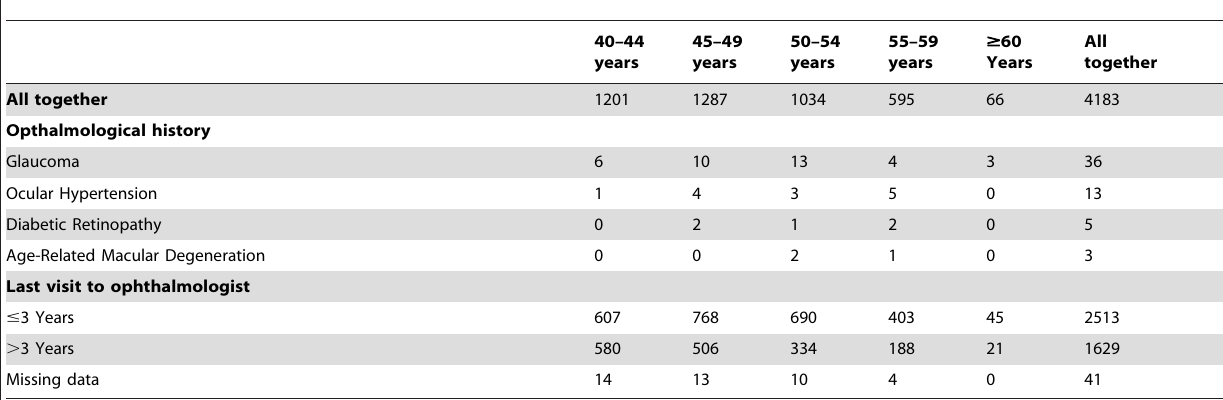
Table 4. Ophthalmological history subdivided in glaucoma, ocular hypertension, diabetic retinopathy, age-related macular degeneration together with the last visit to ophthalmologist